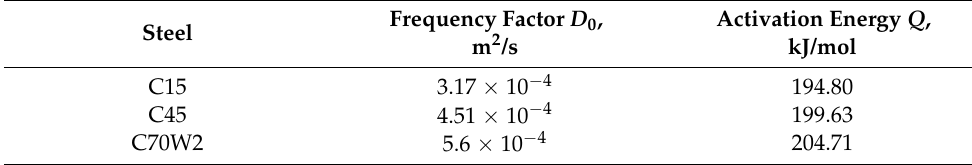
Table 3. Values of the frequency factor and the activation energy